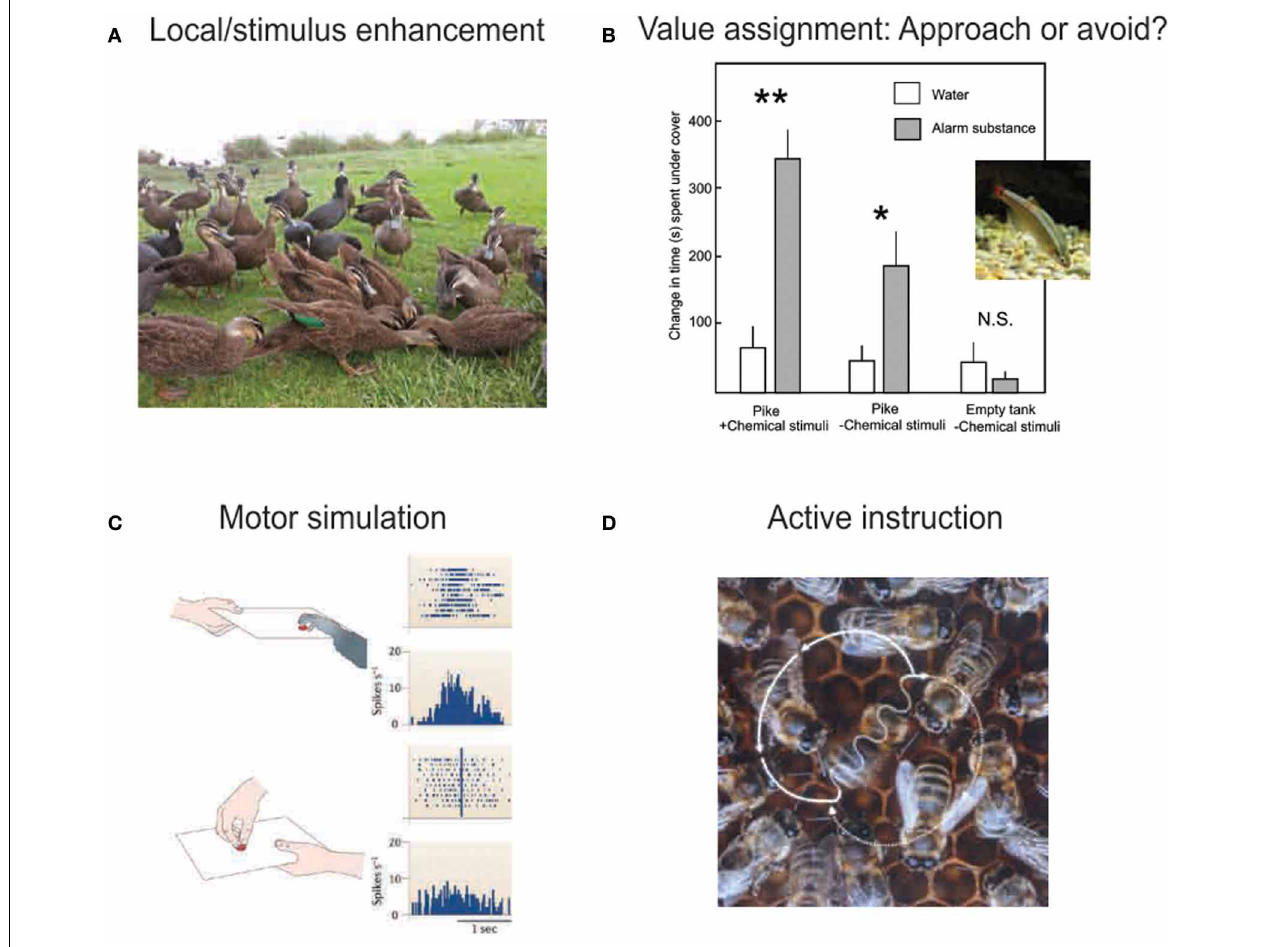
Figure modified with permission from (Chivers and Smith, 1994). Minnow image by Sanse, via Wikimedia Commons. (C) Although few non-human species have been found to imitate other individuals in the strict sense, the observation and performance of motor behaviors are known to activate overlapping neural circuitry. “Mirror neurons” in the frontal cortex of macaque monkeys fire both when performing a motor act and when watching another individual perform the act. This could provide a mechanism by which appropriate behavior is “primed” in a naive individual that observes a knowledgeable conspecific. Figure reproduced with permission from (Iacoboni and Dapretto, 2006). (D) In the process of active instruction, specific information is intentionally communicated to other individuals. This is known to occur in the context of the bee waggle dance, in which the travel path to a remote nectar site is signaled to other foragers in the hive. Image by J. Tautz and M. Kleinhenz, Beegroup Würzburg, via Wikimedia